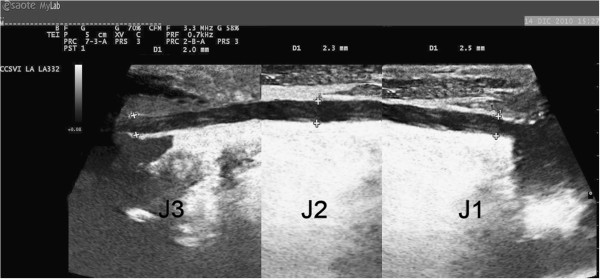
An hypoplastic IJV (cylindrical appearance). The diameter (between 2.0 and 2.5 mm) is broadly similar for all lengths.